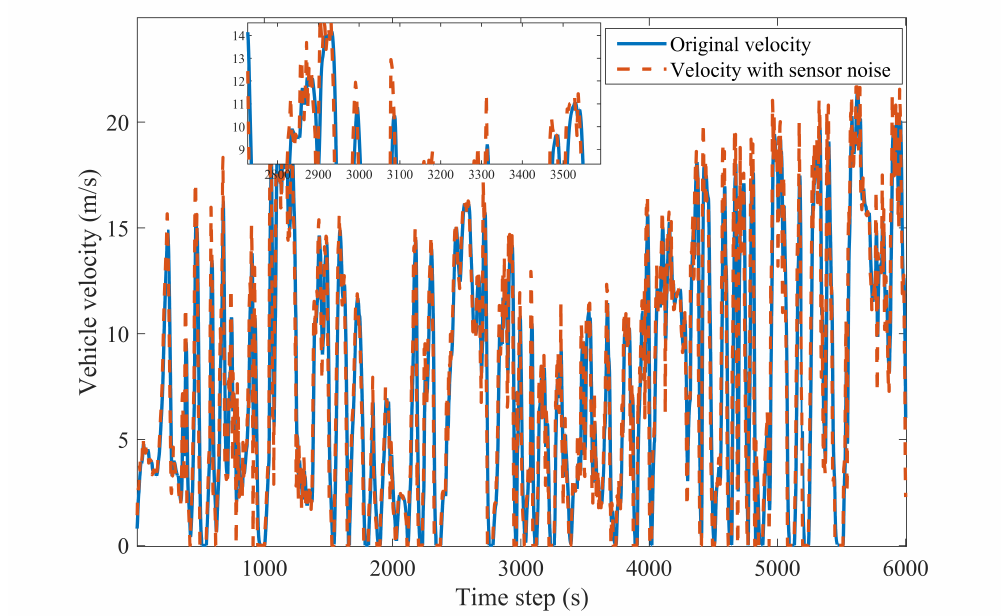
Figure 18. The real driving cycle with sensor